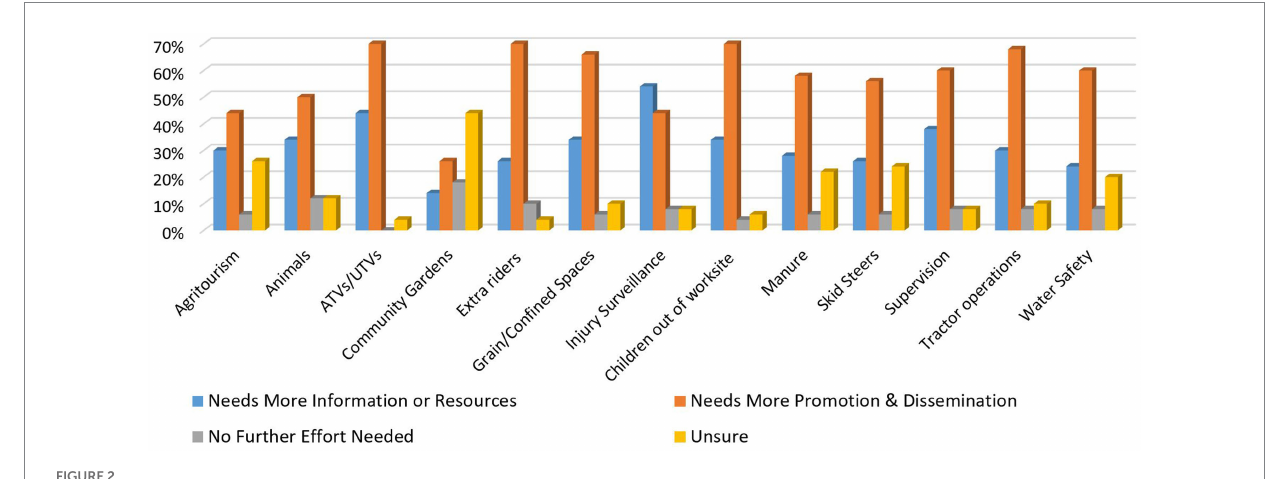
FIGURE 2 Child Ag safety and health topic